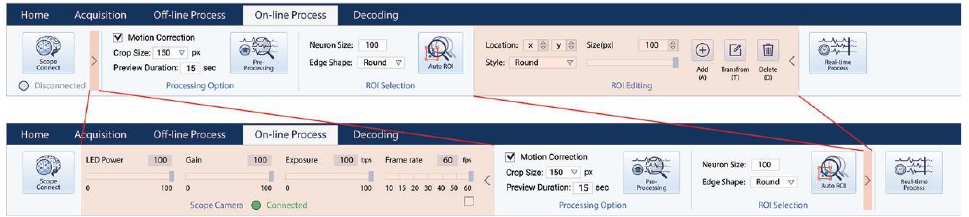
Figure 5. A collapsible and expandable user interface for online processing (illustrated).